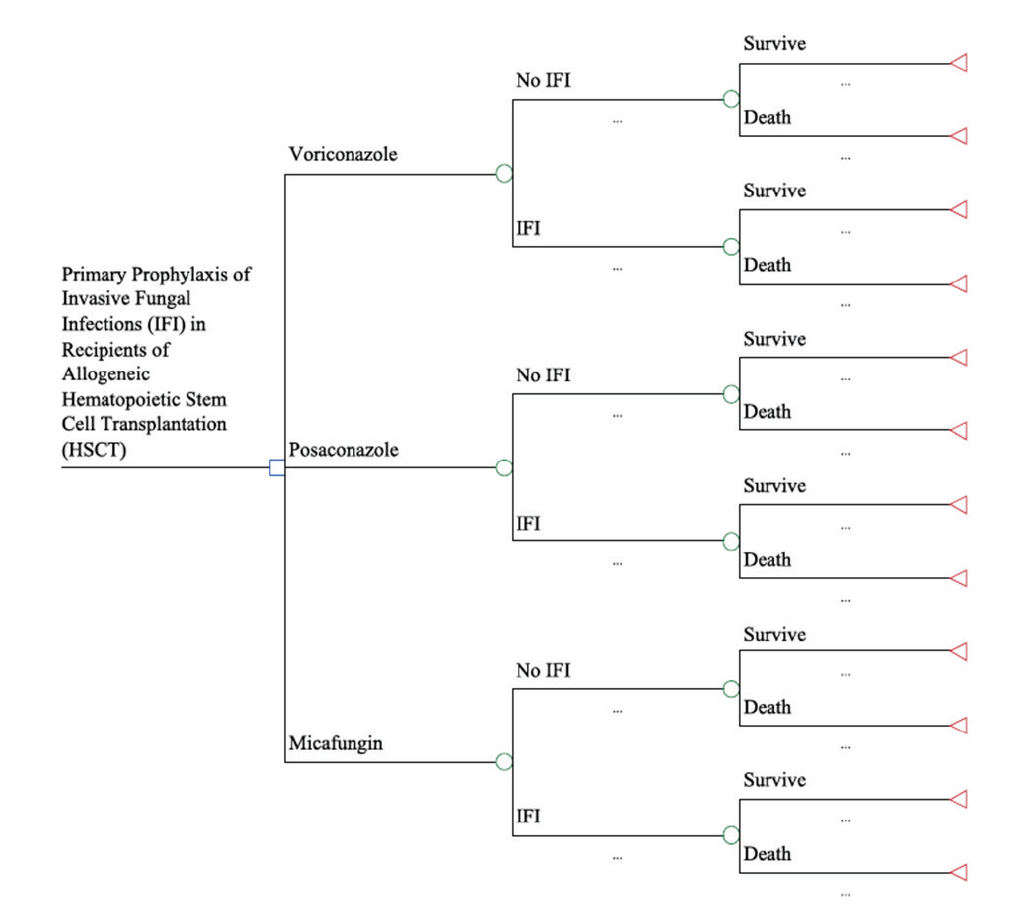
Figure 1. Decision Tree Model